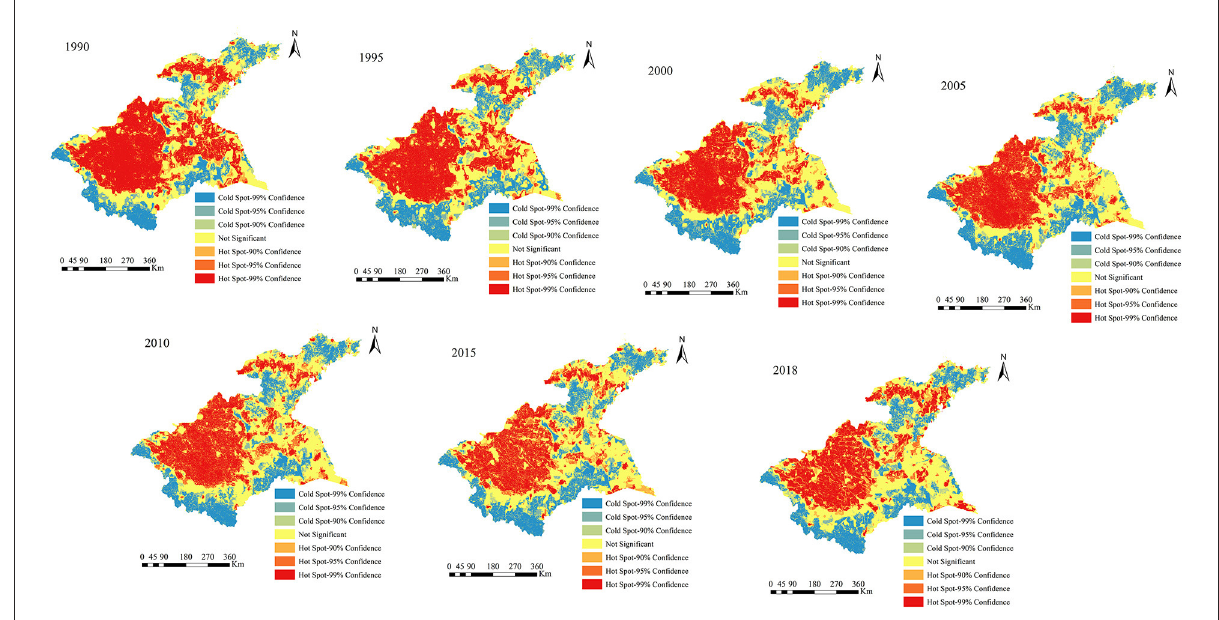
FIGURE8 Migration of centroids of human disturbances over the 1990–2018